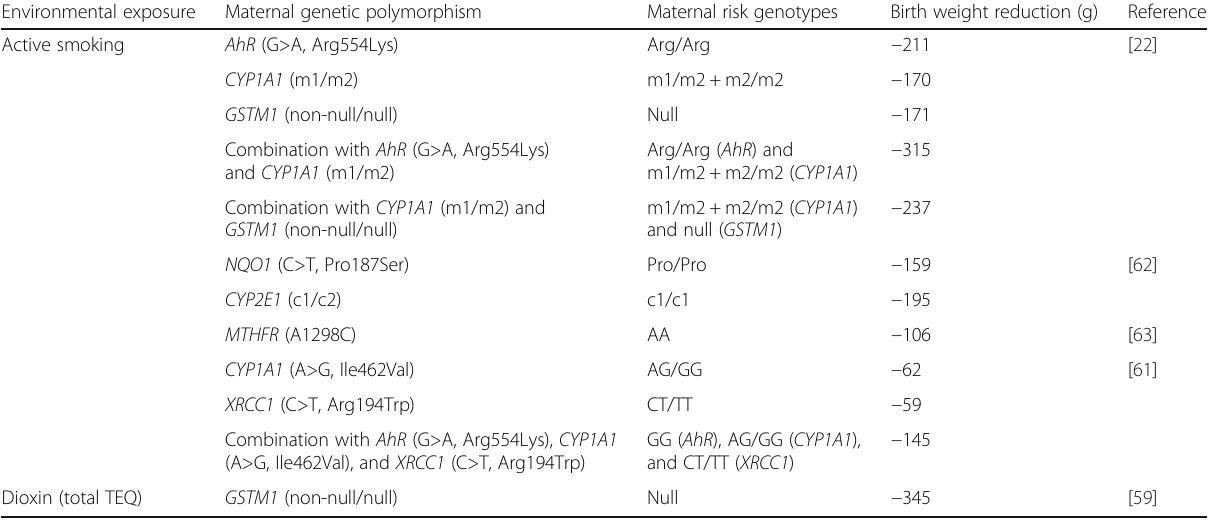
Table 11 Adverse effects of infant birth weight in relation to maternal environmental exposure and genetic polymorphisms Environmental